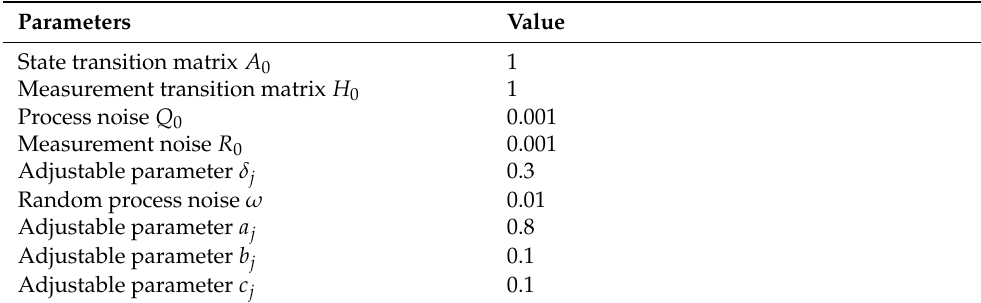
Table 2. Parameters of attitude estimation for suppressing maneuvering acceleration interference in simulation.